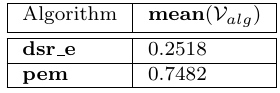
Table 2: Example 4.2. The table shows the mean of the criterion V (defined in Eq. (33)) for dsr e and pem based on random discrete state space model Monte Carlo